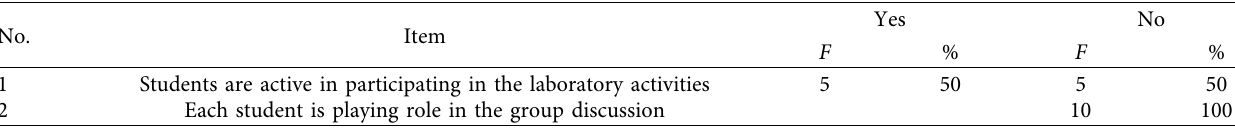
Table 7: Student activities.